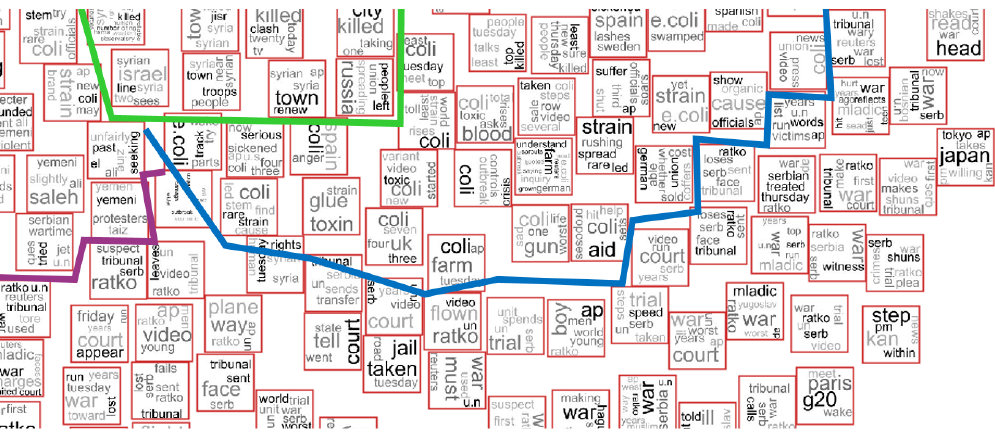
Figure 12. Frontier identification based on individual inspection of the tag clouds computed for each